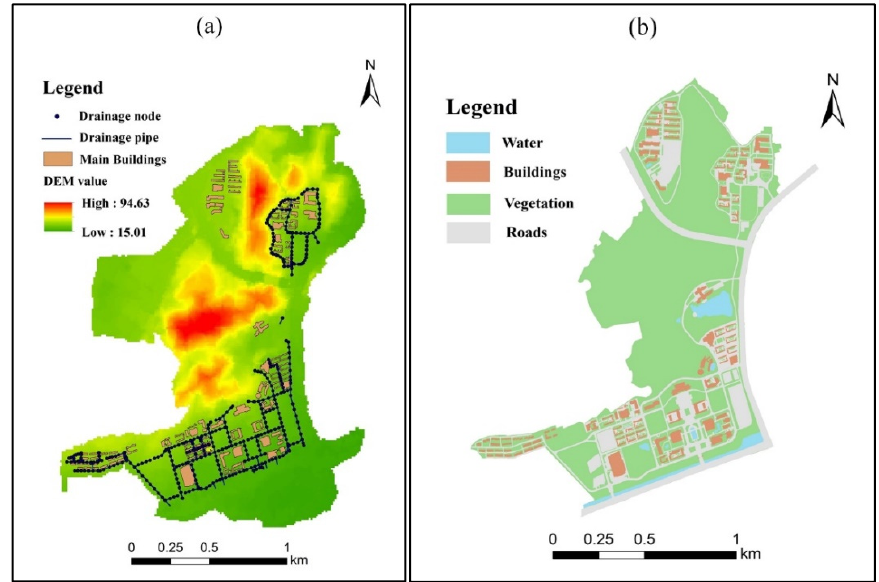
Figure 16. Visualization of raw data in experimental area. DEM data ( a ) land use data ( b ). (5) Land use